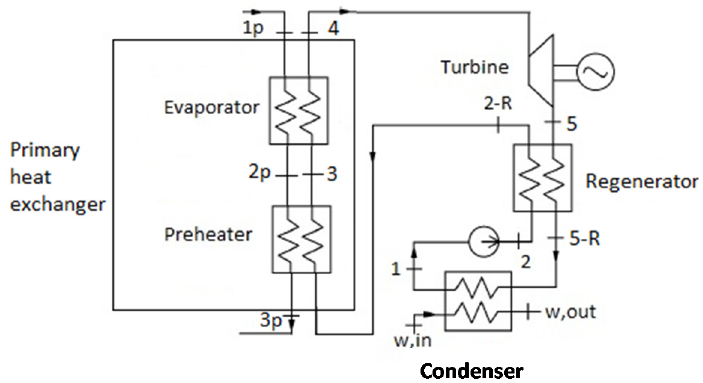
Figure 1. Organic Rankine Cycle (ORC) power